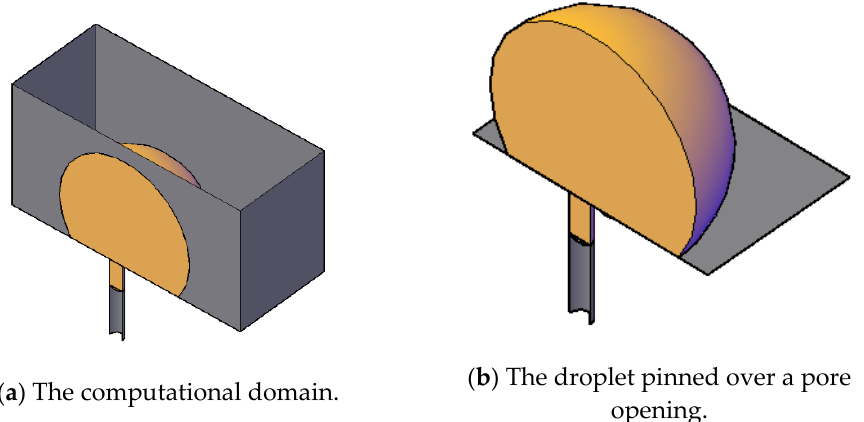
Figure 11. Pictorial schematic view of the computational domain ( a ) (note that the top face has been removed to show the droplet) and of the droplet ( b ) upon permeation through the pore opening.